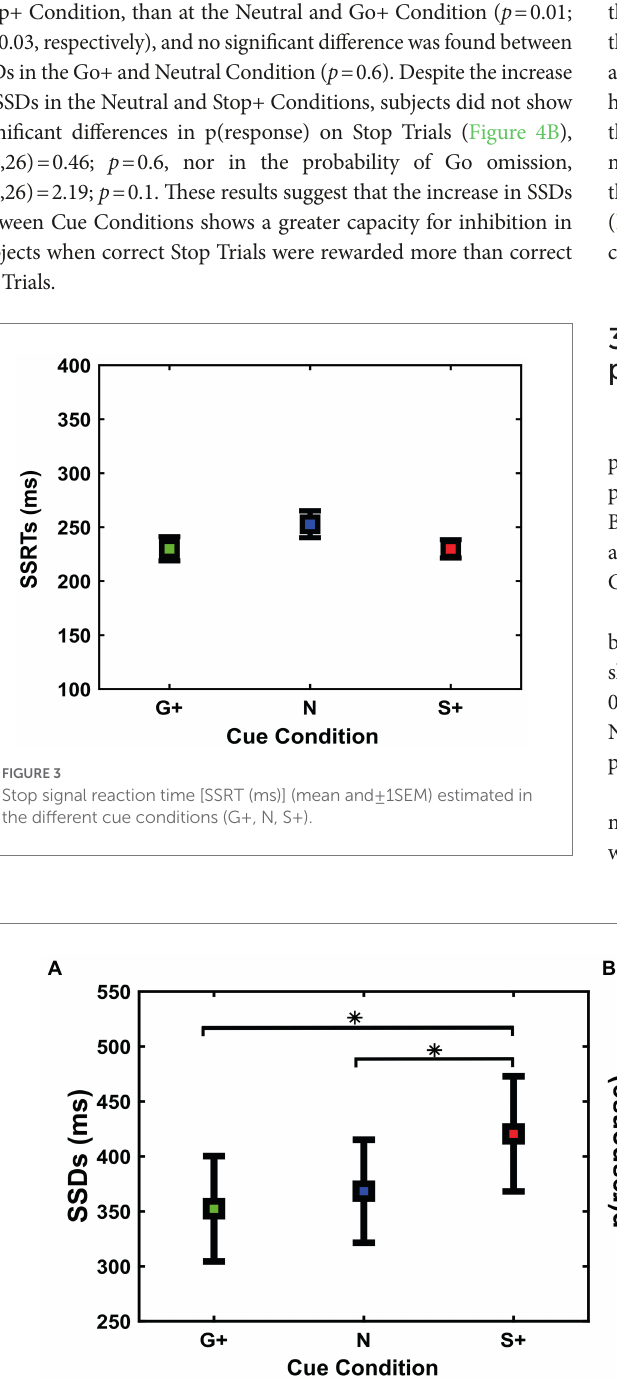
FIGURE 4 (A) Average stop-signal delays (SSD) (mean and ± 1SEM) and (B) probabilities to respond to the stop-signal [p(response)] (mean and ± 1SEM) as a function of cue conditions (G+, N,